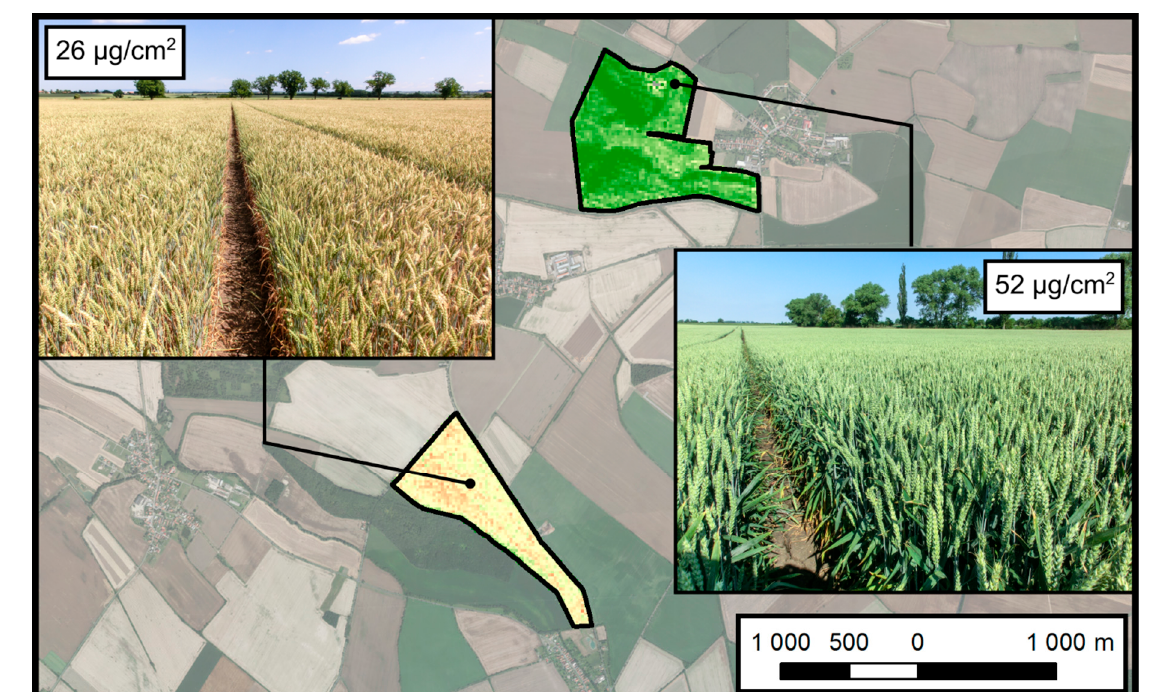
Figure 11. Example of leaf chlorophyll content estimation for two winter wheat parcels demonstrating differences in current maturity status as of 20 June 2017.